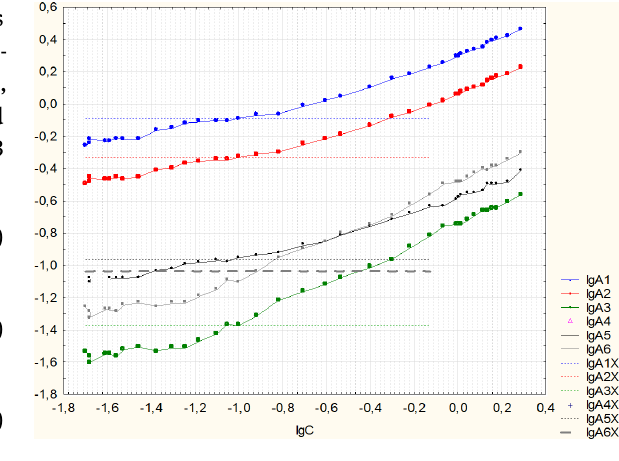
Figure 13. Detection of methane at a concentration of 0.109 vol.% using a calibration portrait for a ZnO-based sensor.